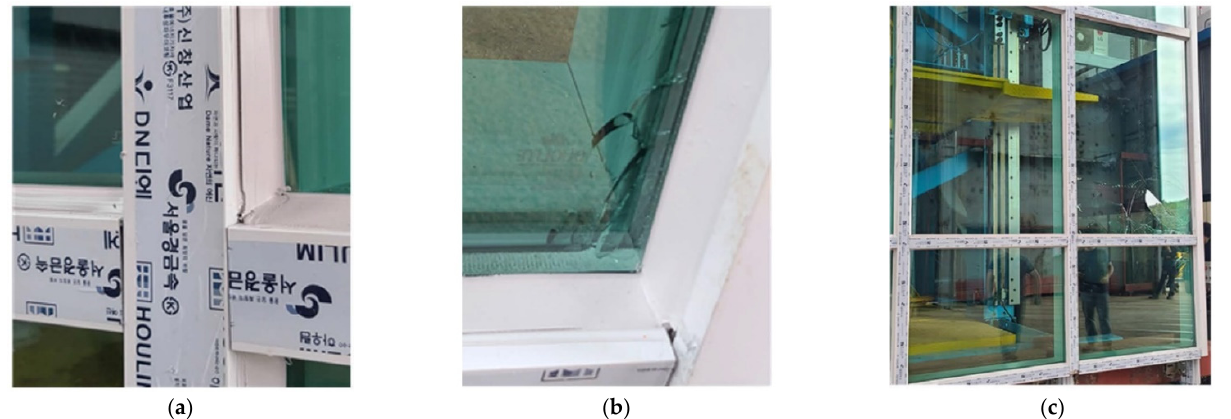
Figure 13. States of non-seismic curtain wall after the dynamic racking crescendo test: ( a ) silicone cracks (42 mm); ( b ) glass cracks (60 mm); ( c ) glass fallout (90 mm).